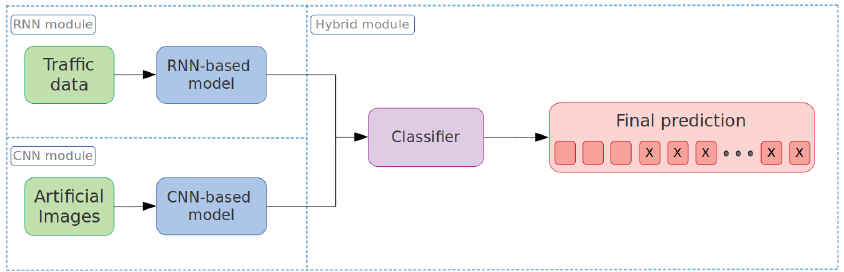
Figure 8. RNN-CNN-Classifier hybrid model architecture. Green refers to the input information, blue to the DL model elements, purple to intermediate elements, and red to the output prediction.